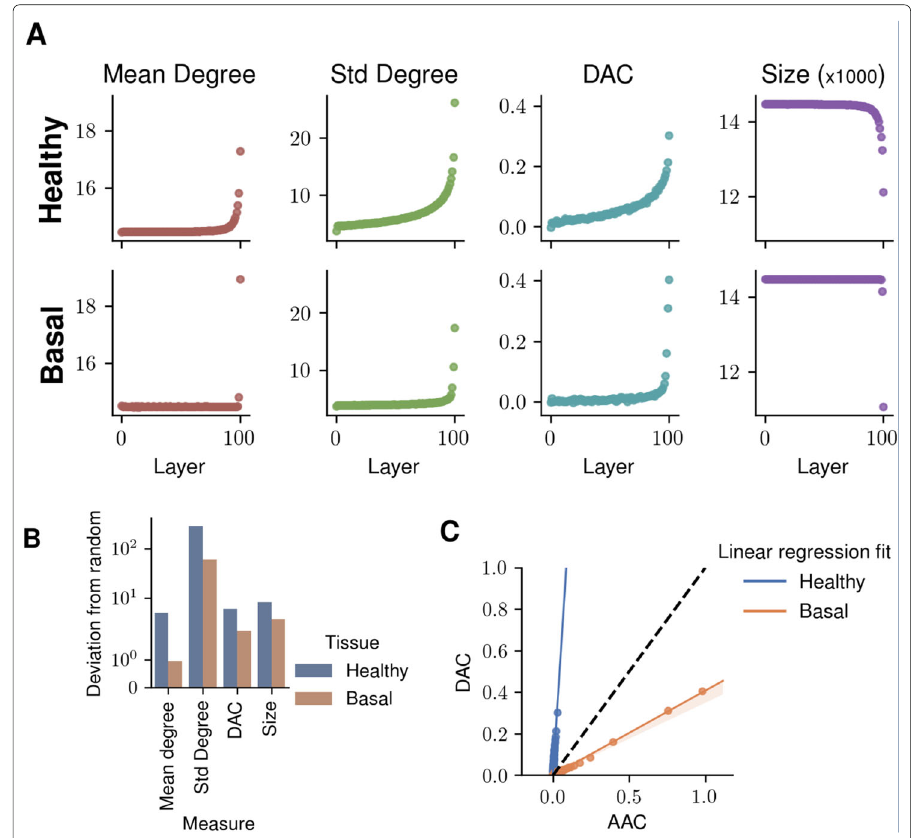
Fig. 3 Structural evolution of the gene co-expression networks of Basal and healthy tissues. a Each column is a different structural measure, namely the mean and standard deviation of the degree, the degree assortativity coefficient (DAC), and the size or number of nodes (in thousands of nodes). b Structural deviation from random of the GCN of each tissue, where random, for each structural measure is taken as the structural value of layer 0, representing co-expression noise. The deviation is the sum of the absolute differences of each layers’ structural value from random. c Relation between the (chromosome) attribute assortativity (AAC), and degree assortativity (DAC) coefficients of the GCN of healthy and Basal tissues. Blue and orange lines are simple regression models of each relation, where shadowed background represents the 95% confidence interval of the model. The black dotted line is the identity line (y=y), and is added for